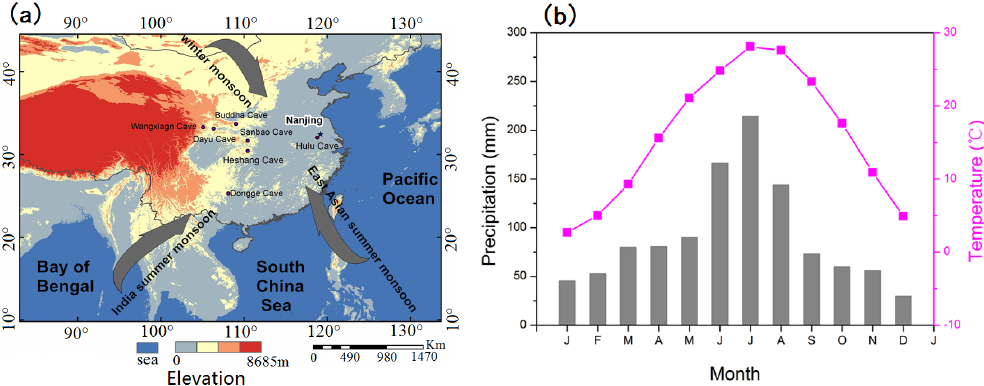
Figure 1. (a) Elevation map of China; the study site Nanjing is marked by a black star. Black dots indicate the cave locations mentioned in this study: Hulu, Dongge, Heshang, Sanbao, Wanxiang, Buddha, and Dayu. Grey arrows indicate the dominant circulation patterns over the region in summer and winter. (b) Monthly average temperature and precipitation from 1981 to 2010 at Nanjing (data from the China Meteorological Data Sharing Service